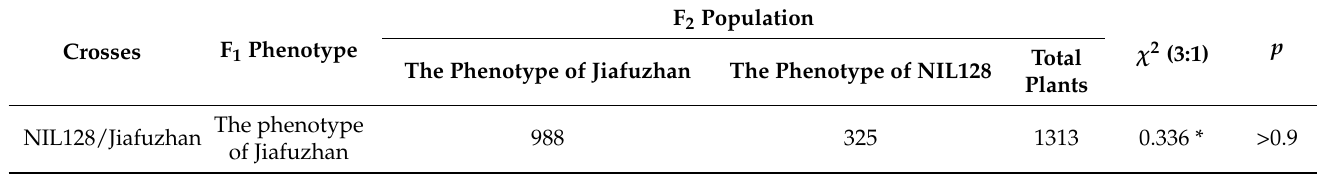
Table 2. Segregations of F 2 populations crossed by NIL128.